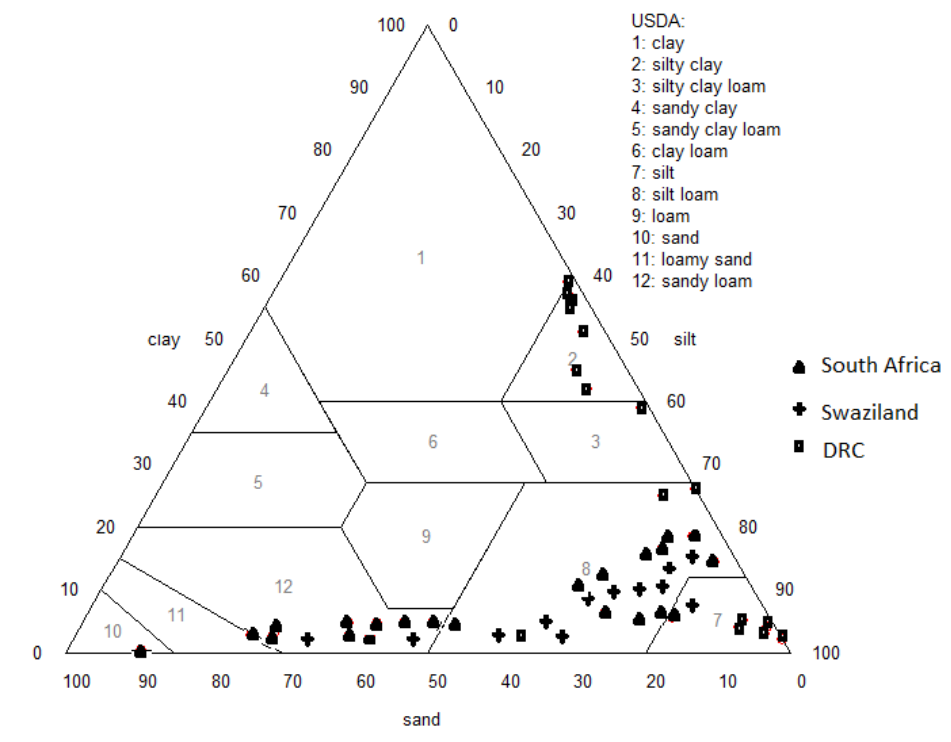
Figure 3. Textural triangle showing the textural classes of the geophagic samples from different